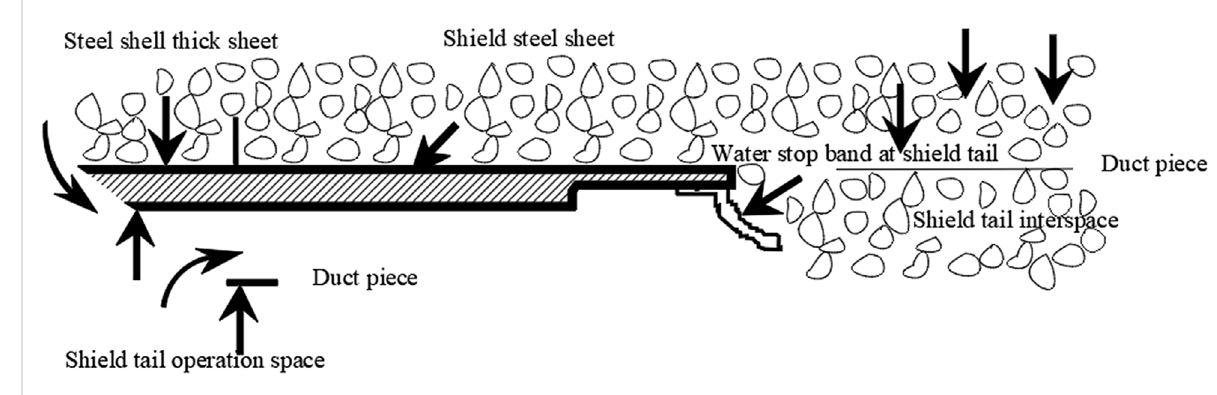
FIGURE 3 Mechanism of stratum loss around shield